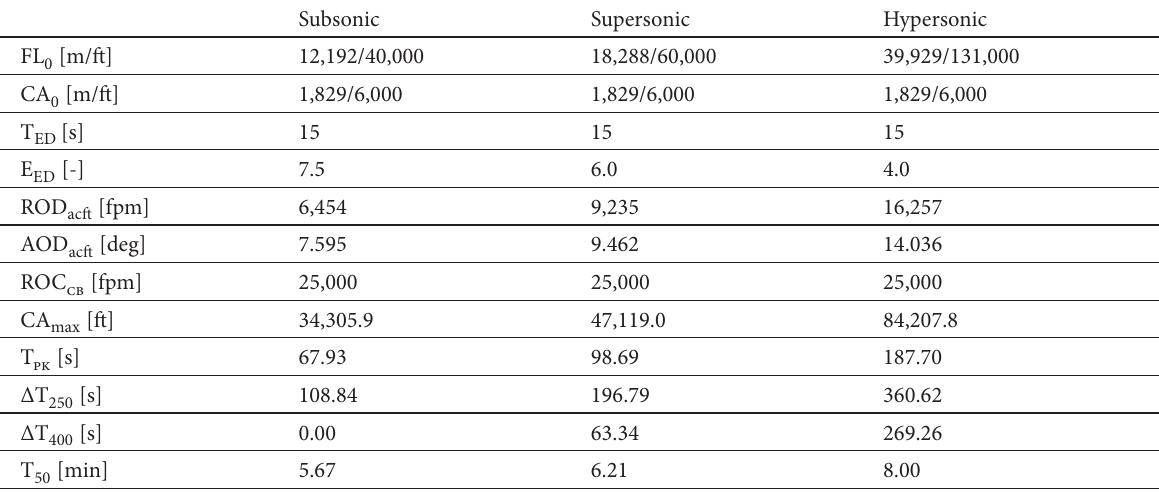
Table 2. Decompression of subsonic, supersonic and hypersonic aircraft flying at respective operating altitudes with identical average cabin climbs and crew reaction